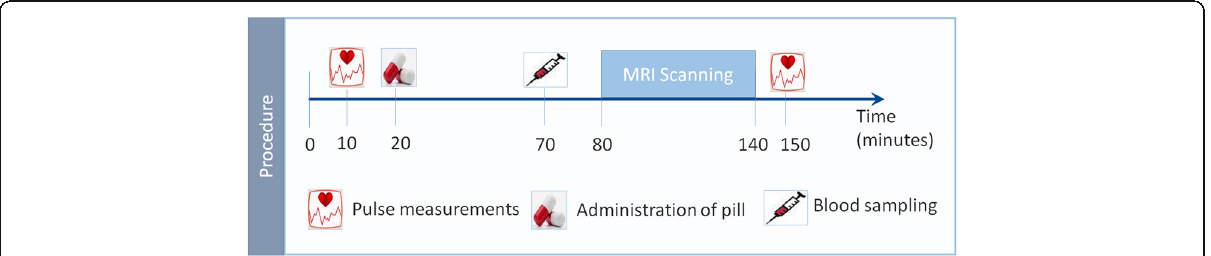
Fig. 1 Procedure in healthy subjects group. Timeline of procedures taking place at both scanning sessions (metoprolol and placebo session). Each session started out with pulse measurement and administration of a pill, either treatment or a placebo in a blinded fashion. A blood sample was drawn after a waiting period of 50 min that allowed the drug to reach its maximum plasma concentration while the participant completed the experiment in the scanner. Blood samples were drawn to determine plasma concentration of metoprolol. Then a paradigm of nociceptive trigeminal stimulation was conducted during fMRI, followed by a second pulse measurement after